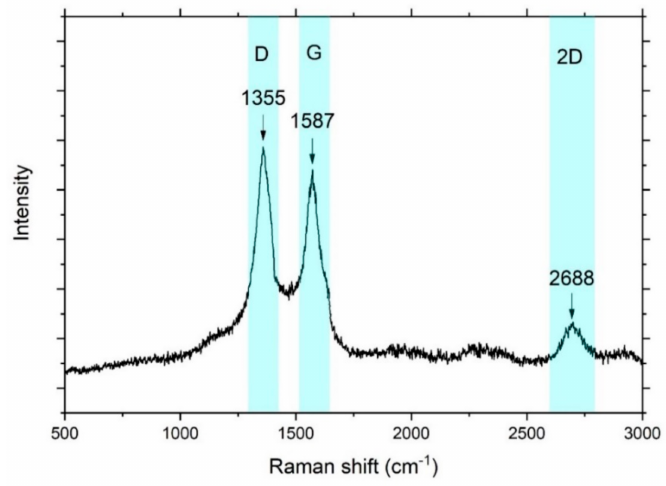
Figure 3. Raman spectra of graphene/ f -MWCNT nanocomposite @PdMg